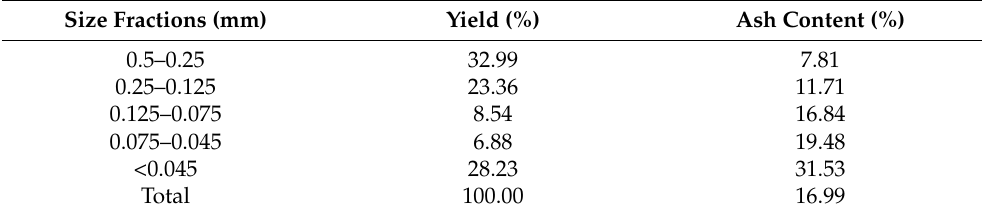
Table 2. Particle size distribution of the LRC sample.